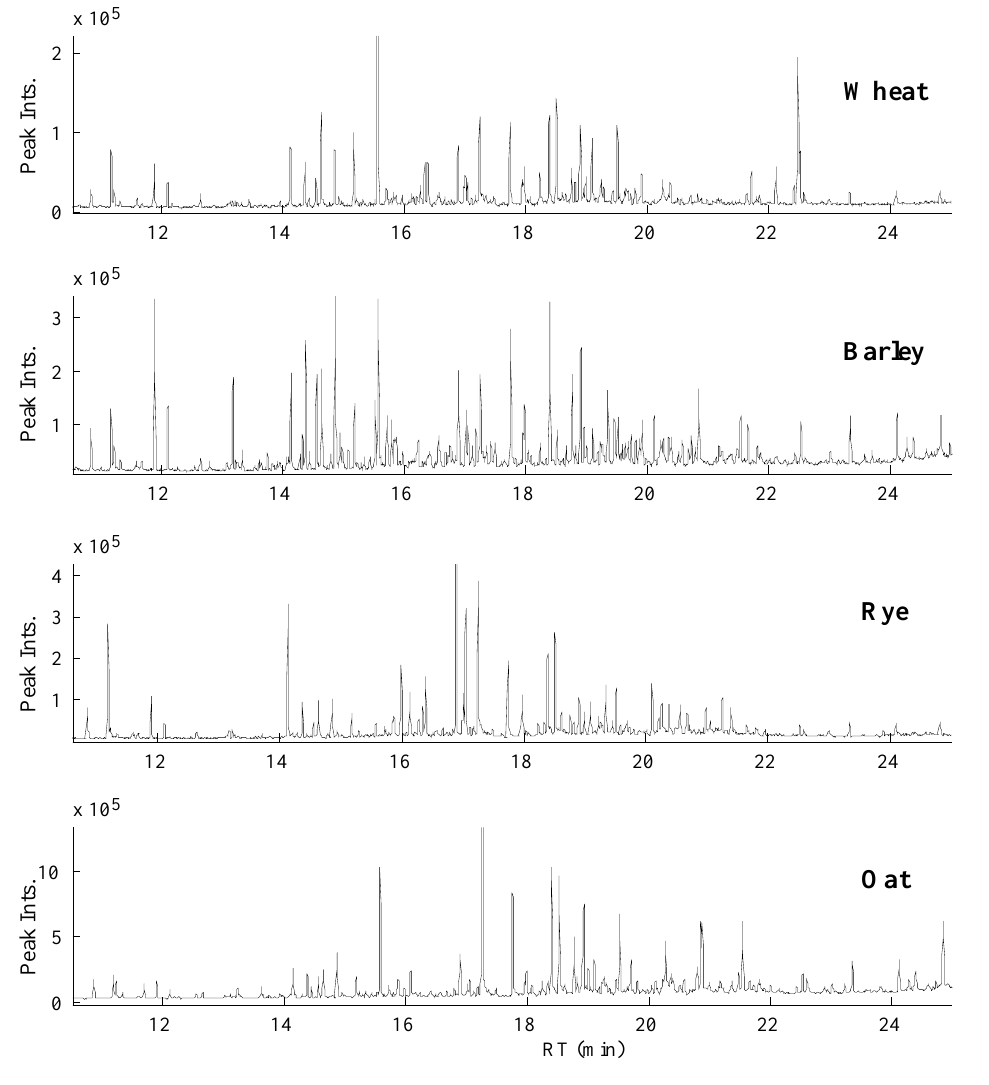
Figure 1. The total ion current (TIC) chromatograms of GC-MS data obtained on wheat, barley, rye and oat metabolite